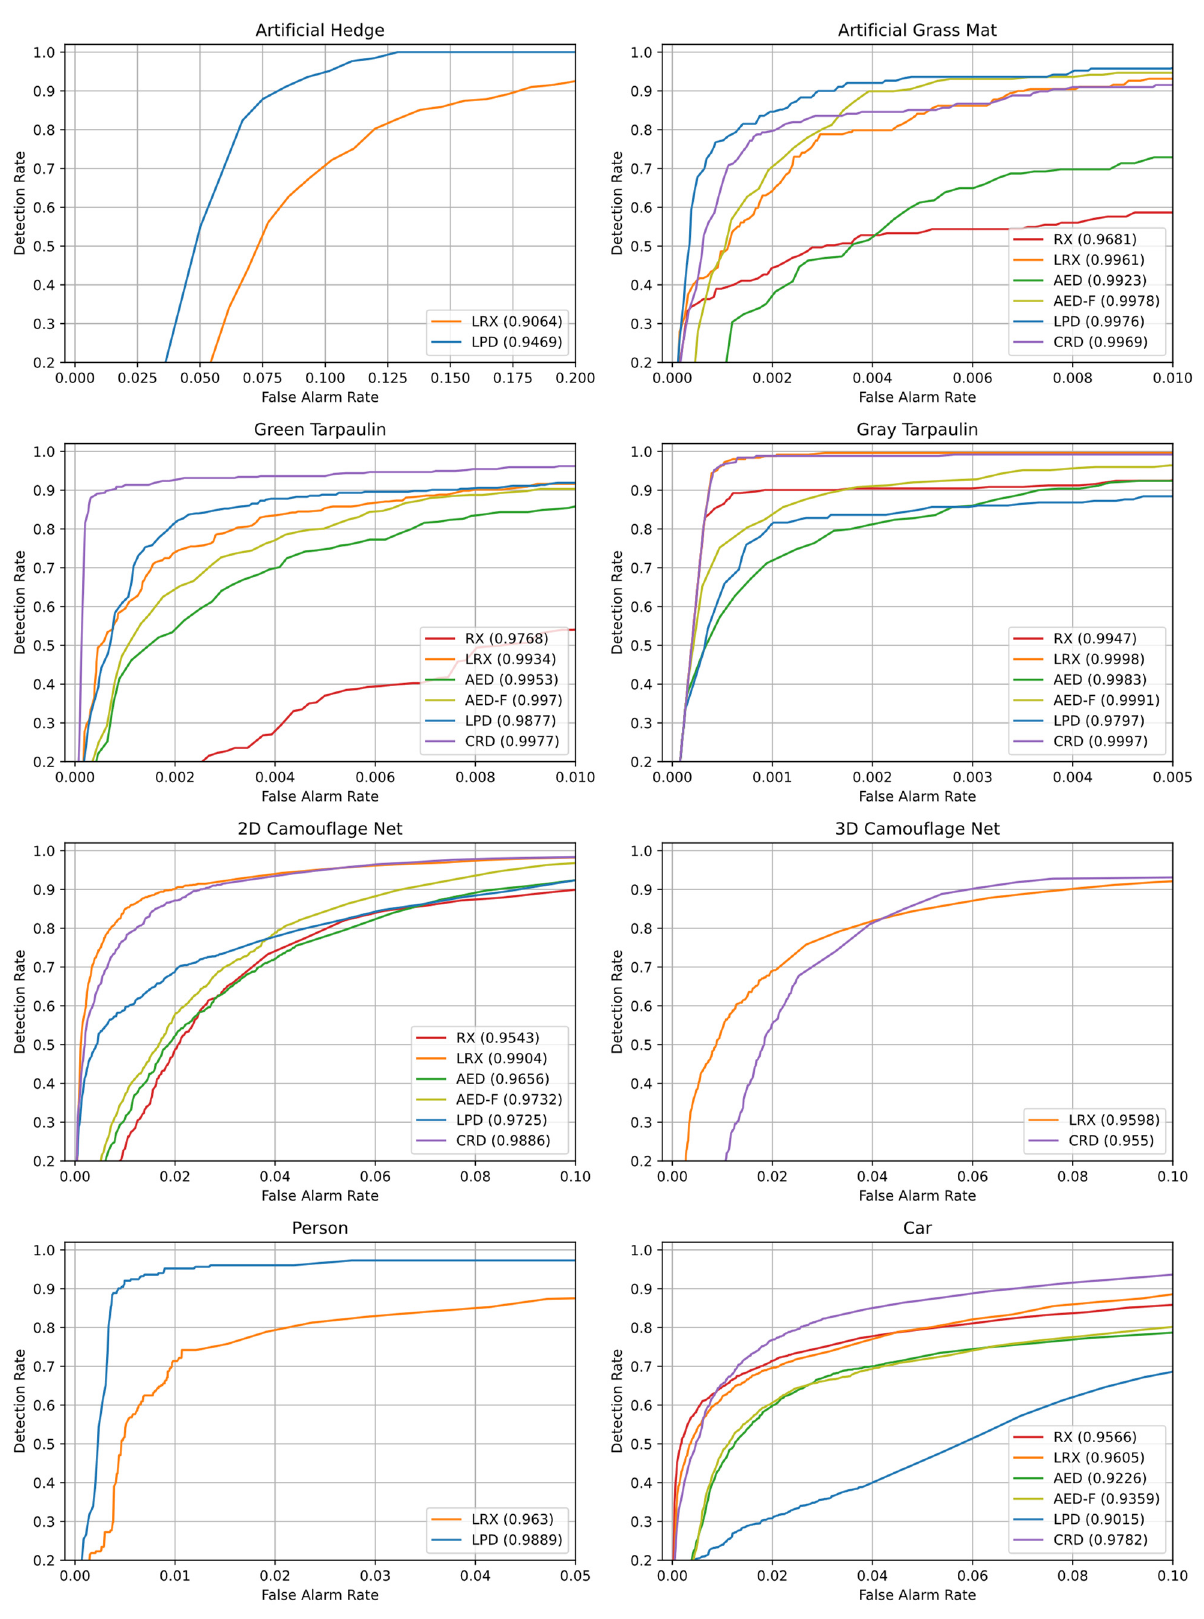
Figure 7. Receiver operating characteristics (ROCs) and areas under the curve (AUCs) for individual target classes of every method applied on the raw version of MUCAD. Algorithms that achieved an AUC less than 0.9 are not included. Note that each plot has individual limits for the abscissa.